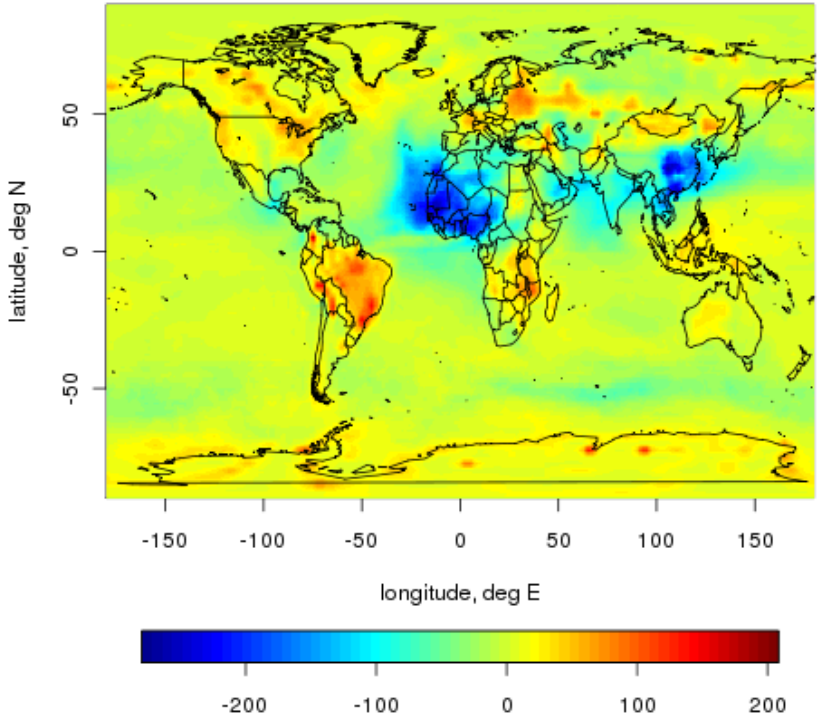
Figure 1. Illustration of the difference in surface radiation (Air Mass = 2), here direct normal irradiance for March, induced by the use of different aerosol climatologies (Kinne versus Global Aerosol Data Set/Optical Properties of Aerosols and Clouds (GADS/OPAC), see Section 2 for further details about the climatologies). The large differences in Direct Normal Irradiance (DNI) illustrates that the mix of different data sources is expected to lead to serious inhomogeneities in climate data